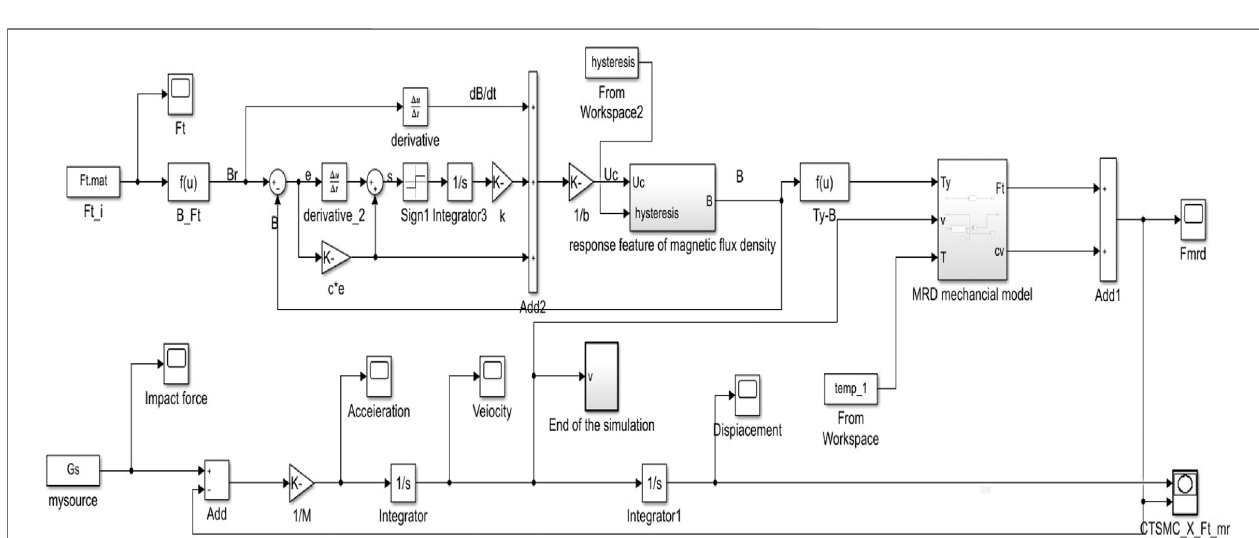
FIGURE 9 | Simulation block diagram of MR impact buffer control system containing disturbance based on the CTSMC.